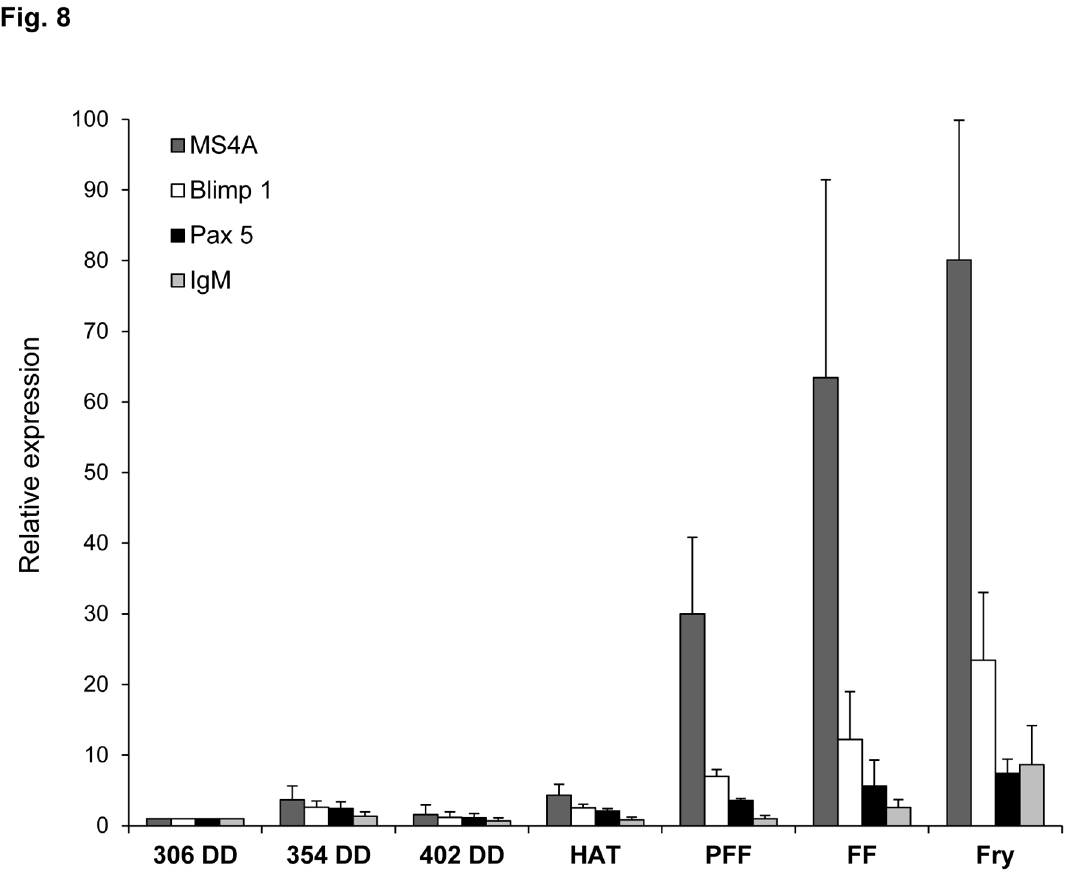
Figure 8. Levels of transcription of B cell markers in early rainbow trout stages. Transcriptional levels of MS4A, Blimp1, Pax5 and IgM during trout early development at different stages. The relative expressions to the endogenous control EF-1α were calculated for each sample and then means values from day 1 were set as 1, and means from the other stages were relative to the first sampling point. Results from 5 individuals per stage ± SD are shown. DD: days degree; HAT: hatching; PFF: pre first feeding ; FF: first